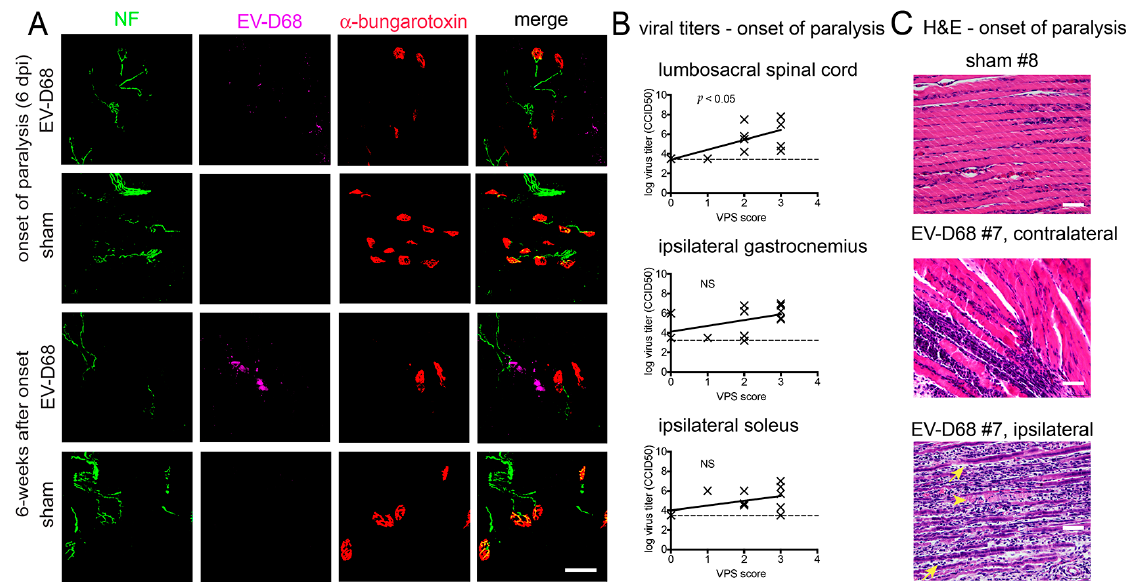
Figure 10. Reduced neuromuscular junction (NMJ) innervation in gastrocnemius muscles of AG129 mice infected with EV-D68. ( A ) neurofilament (NF) ir, EV-D68 ir, fluorescence-tagged α -btx in sham- and EV-D68-infected mice at onset of paralysis (6 days after viral challenge) and at six weeks after paralysis onset; ( B ) EV-D68 infectious viral titer (50% cell culture infectious dose, CCID50) versus motor score at onset of paralysis at 7–8 dpi; ( C ) Hematoxylin-eosin (H&E) staining of gastrocnemius muscle, image of sham #8 and image of contralateral EV-D68 #7, image of ipsilateral EV-D68 #7 at onset of paralysis at 7–8 dpi. Necrotic myofiber (yellow arrow head). Regenerating myofiber (yellow arrow). 50 µm for all bars. Dotted line indicates limit of detection.